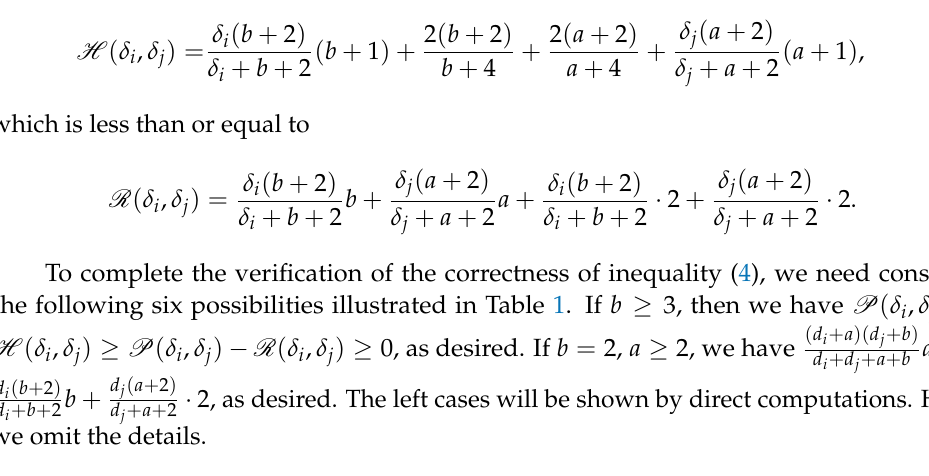
Table 1. Non-negativity of P ( δ i , δ j ) − H ( δ i , δ j ) . ≥ 0 ≥ 0 ≥ 0 ≥ 0 ≥ 0 ≥ 0 b ≥ 3 a ≥ 2, b = 2 a ≥ 3, b = 1 a = 1, b = 2 a = 2, b = 1 a = 1, b =